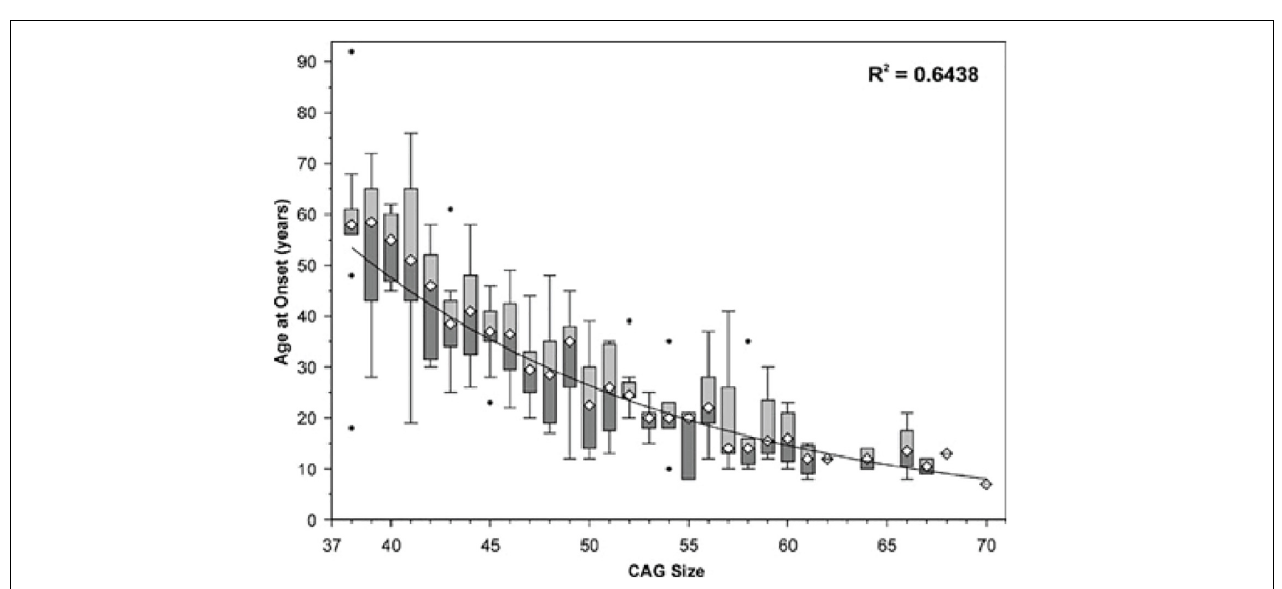
FIGURE 1 | Macular degeneration is a unique feature of SCA7. (Left) A healthy macula (the portion of the retina representing the center of the visual field, which has the highest visual acuity). Adapted from Stanford Medicine, Fundoscopic Exam . (Right) Extreme macular degeneration in late-stage SCA7. Adapted from La Spada, Spinocerebellar Ataxia Type 7 .